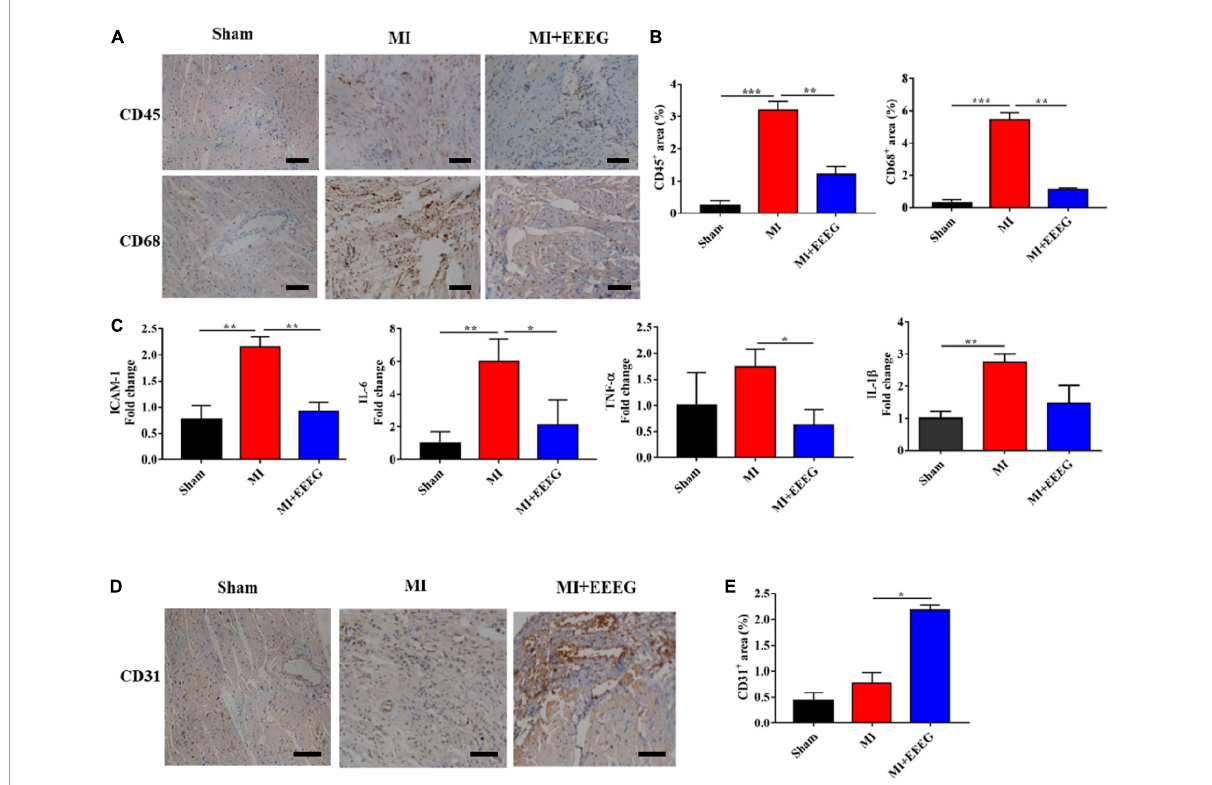
FIGURE3 EG extract (EEEG) attenuates myocardial inflammation after MI. (A) Representative immunohistochemical staining of CD45 and CD68 in the heart tissue from vehicle and EEEG (10 g/kg) treated rats at 4 weeks after MI or sham operation (scale bar, 50 µ m). (B) According to immunohistochemical staining, CD45 + and CD68 + positive areas were quantified using hearts 4 weeks after MI or sham operation from vehicle and EEEG (10 g/kg) treated rats ( n = 8). (C) qRT-PCR analysis of Icam-1 , Il-6 , Tnf- α , and Il-1 β was performed using mRNA isolated from vehicle and EEEG (10 g/kg) treated rat hearts at 4 weeks after MI or sham operation ( n = 8). (D) Immunohistochemical analyses of CD31 in the cardiac tissue at 4 weeks after MI or sham operation (scale bar, 50 µ m). (E) Quantification of CD31 + positive area in vehicle and EEEG (10 g/kg) treated rat hearts 4 weeks after MI or sham operation ( n = 8). Data are mean ± SEM. * P < 0.05, ** P < 0.01, *** P <